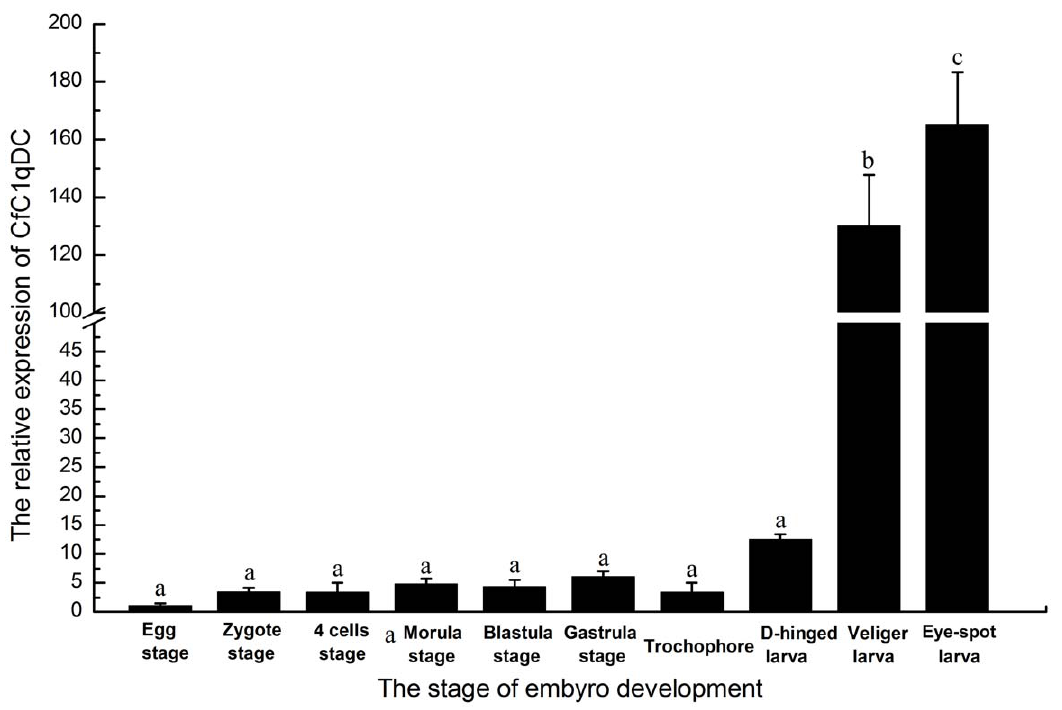
Figure 2. Temporal expression of the CfC1qDC transcripts in the different stages of scallop embryo development. Vertical bars represent the mean 6 S.E. (N=5).